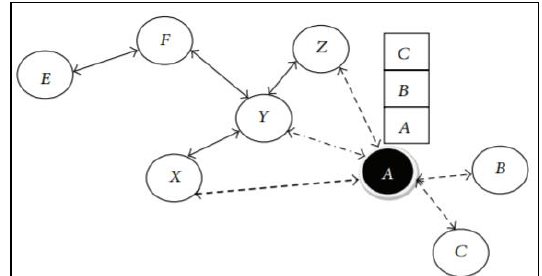
Figure 7:Sybil attacks with multiple ID B.